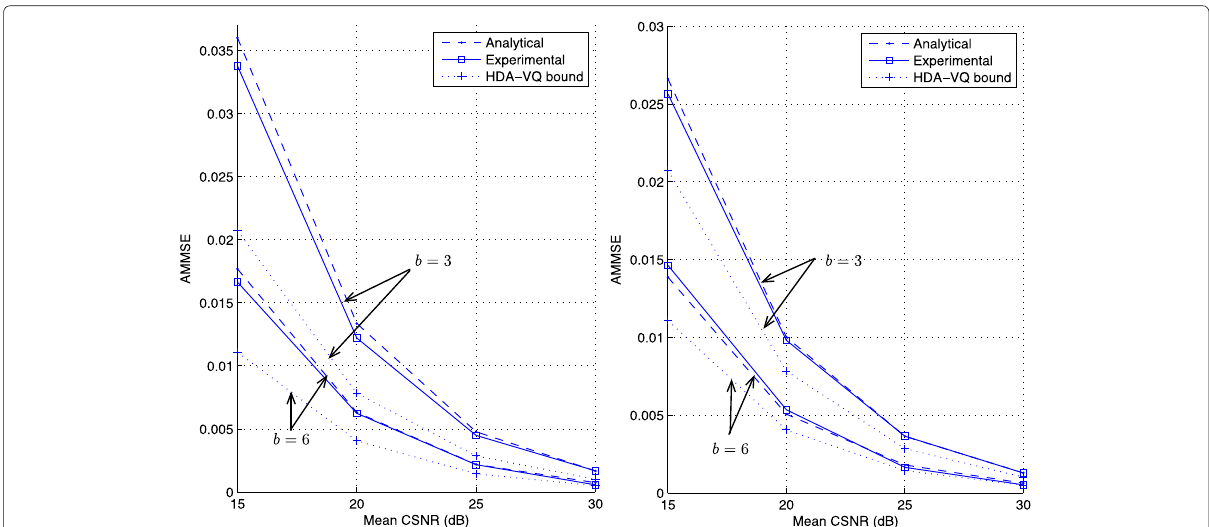
Fig. 3 A comparison of analytical and experimental AMMSEs of HDA systems designed for the unit variance GM(0.9) source, HDA-PQ ( left ), and HDA-TC ( right ) ( b is the bandwidth expansion). ρ and θ o values for HDA-PQ and HDA-TC systems shown here are listed in Table 1. HDA-PQ prediction order is 1, and HDA-TQ transform block size is 8